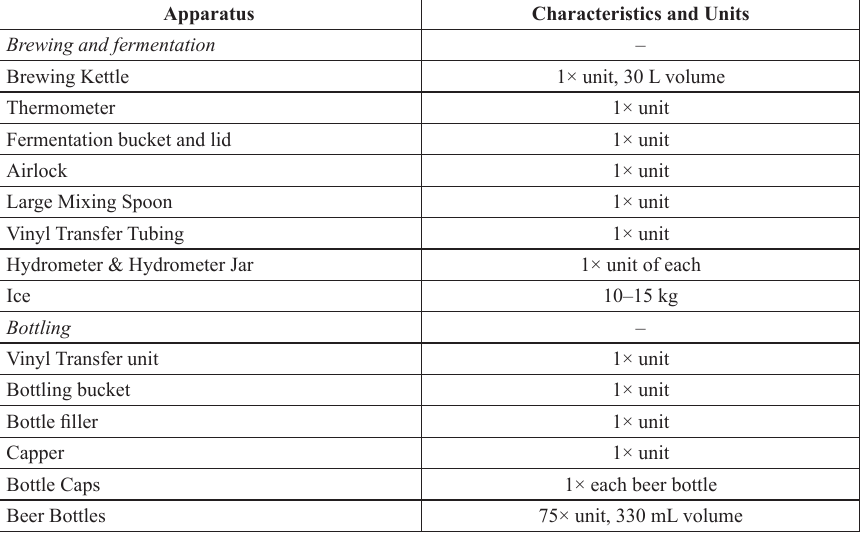
Table 3. Main necessary items for brewing beer from malt extract